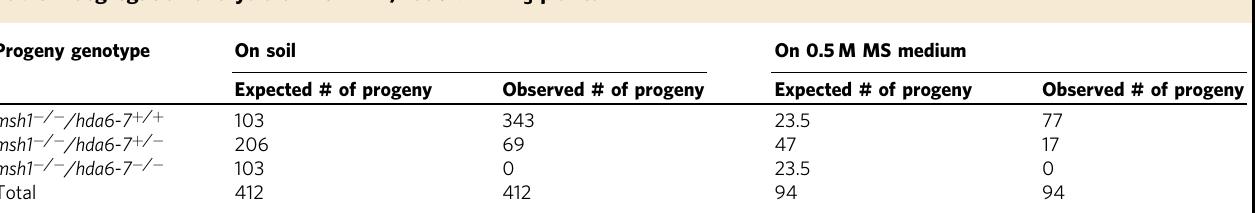
Table 1 Segregation analysis of msh1 − / − / hda6-7 + / − F 3 plants. Progeny genotype On soil On 0.5 M MS medium Expected # of progeny Observed # of progeny Expected # of progeny Observed # of progeny